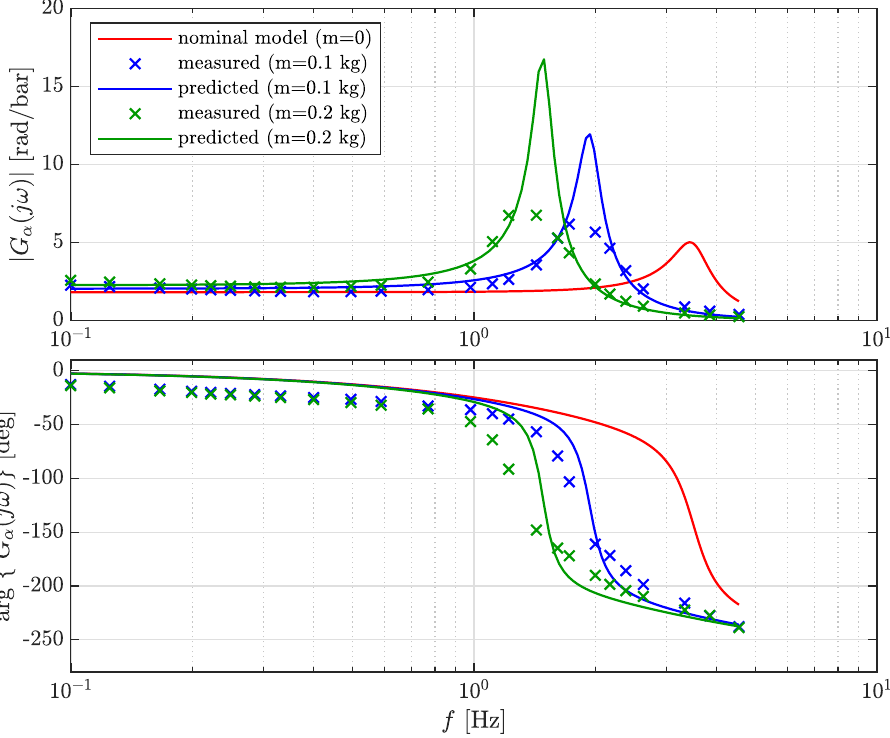
Figure 12. The figure shows a comparison of the frequency response when a payload mass is attached. The solid red line shows the (fitted) frequency response where no mass is attached and is